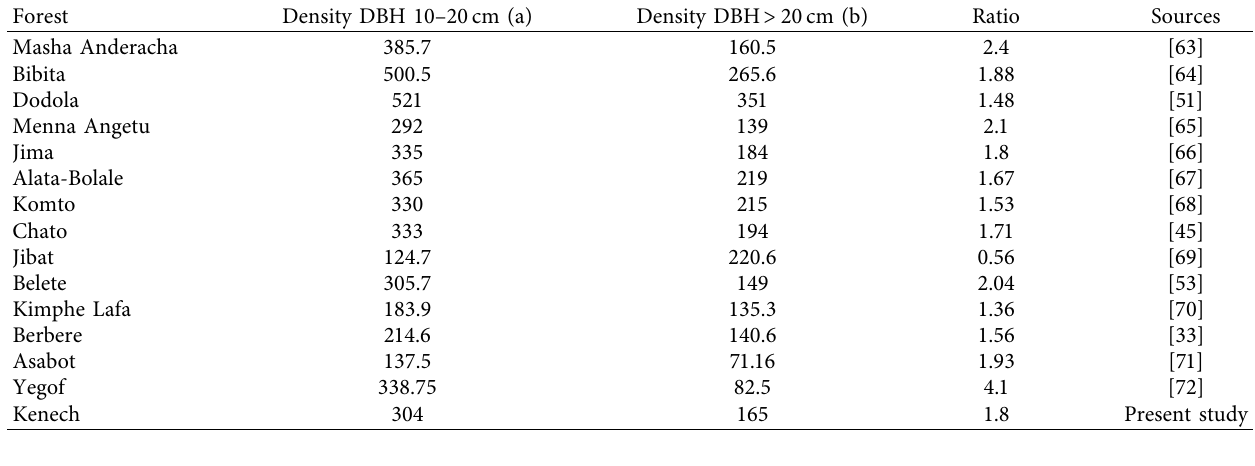
Table 3: Comparisons of tree densities with DBH between 10 and 20 (a) and tree density with DBH > 20cm, (b) from Kenech forest with 10 other forests in Ethiopia.